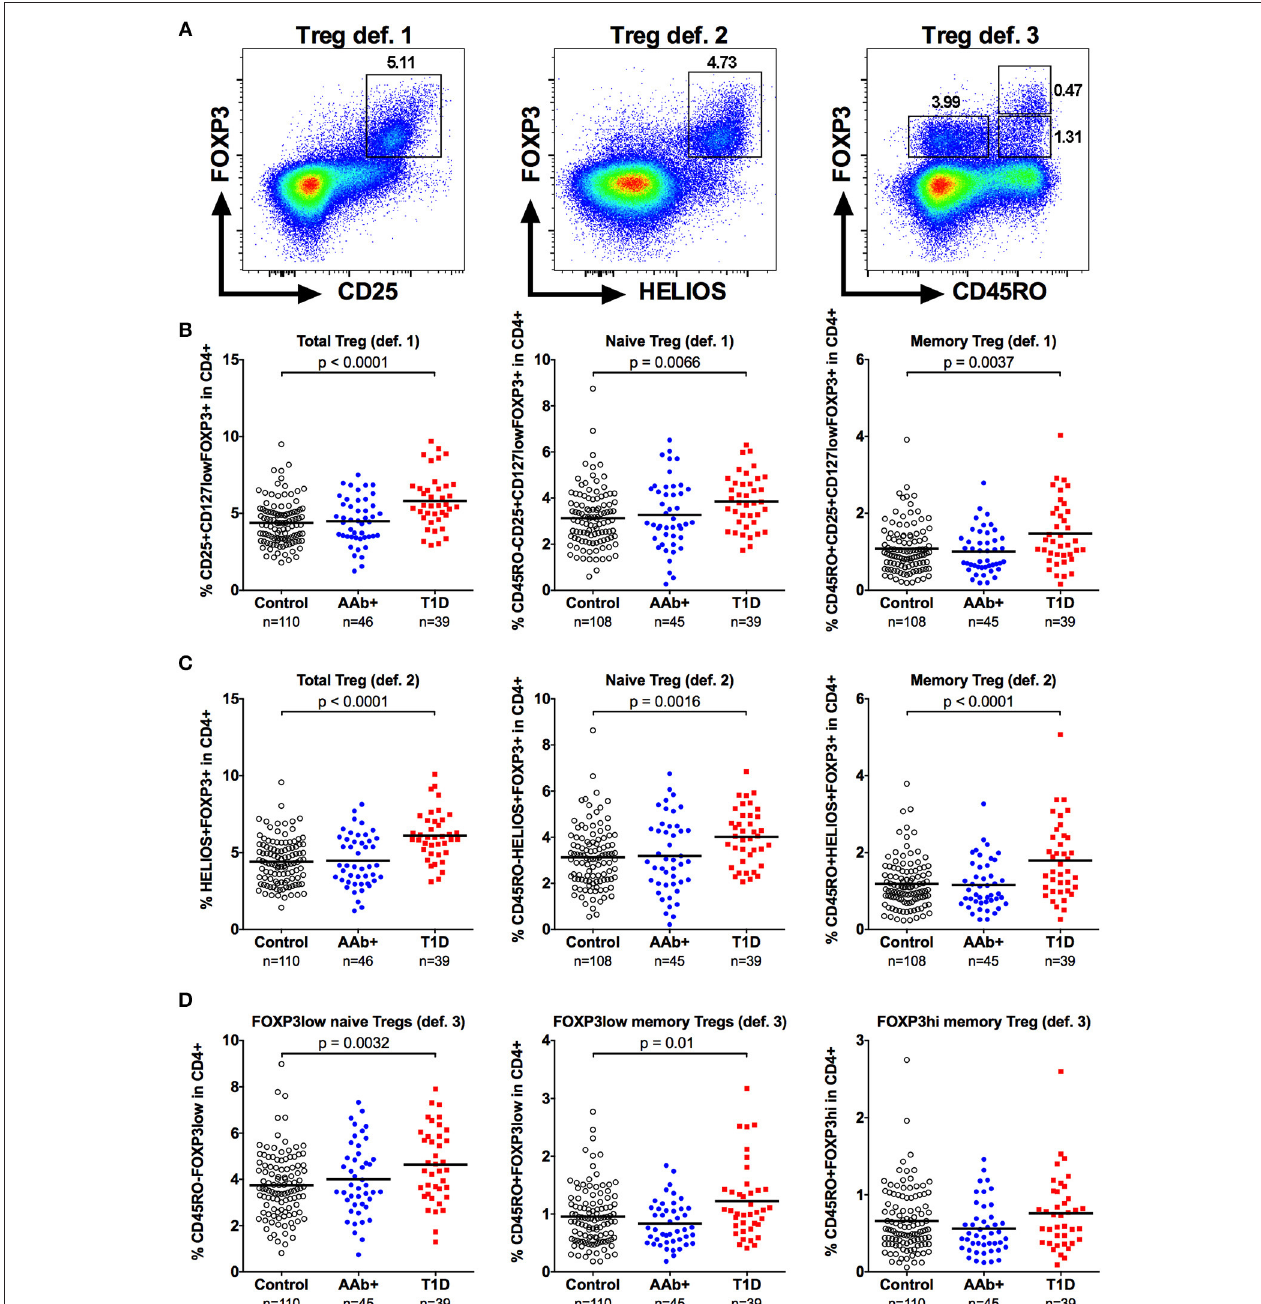
FIGURE 3 | Increased frequencies of FOXP3 + naive and memory Tregs in children with newly diagnosed T1D by different strategies to define Tregs. Tregs were defined either as CD4 + CD25 + CD127lowFOXP3 + (definition 1; A , left), CD4 + HELIOS + FOXP3 + (definition 2; A , middle) or as CD4 + CD45RO-FOXP3low, CD4 + CD45RO + FOXP3low and CD4 + CD45RO + FOXP3hi (definition 3; A , right). Frequencies of definition 1 (B) , definition 2 (C) and definition 3 (D) Tregs in control, AAb + and T1D